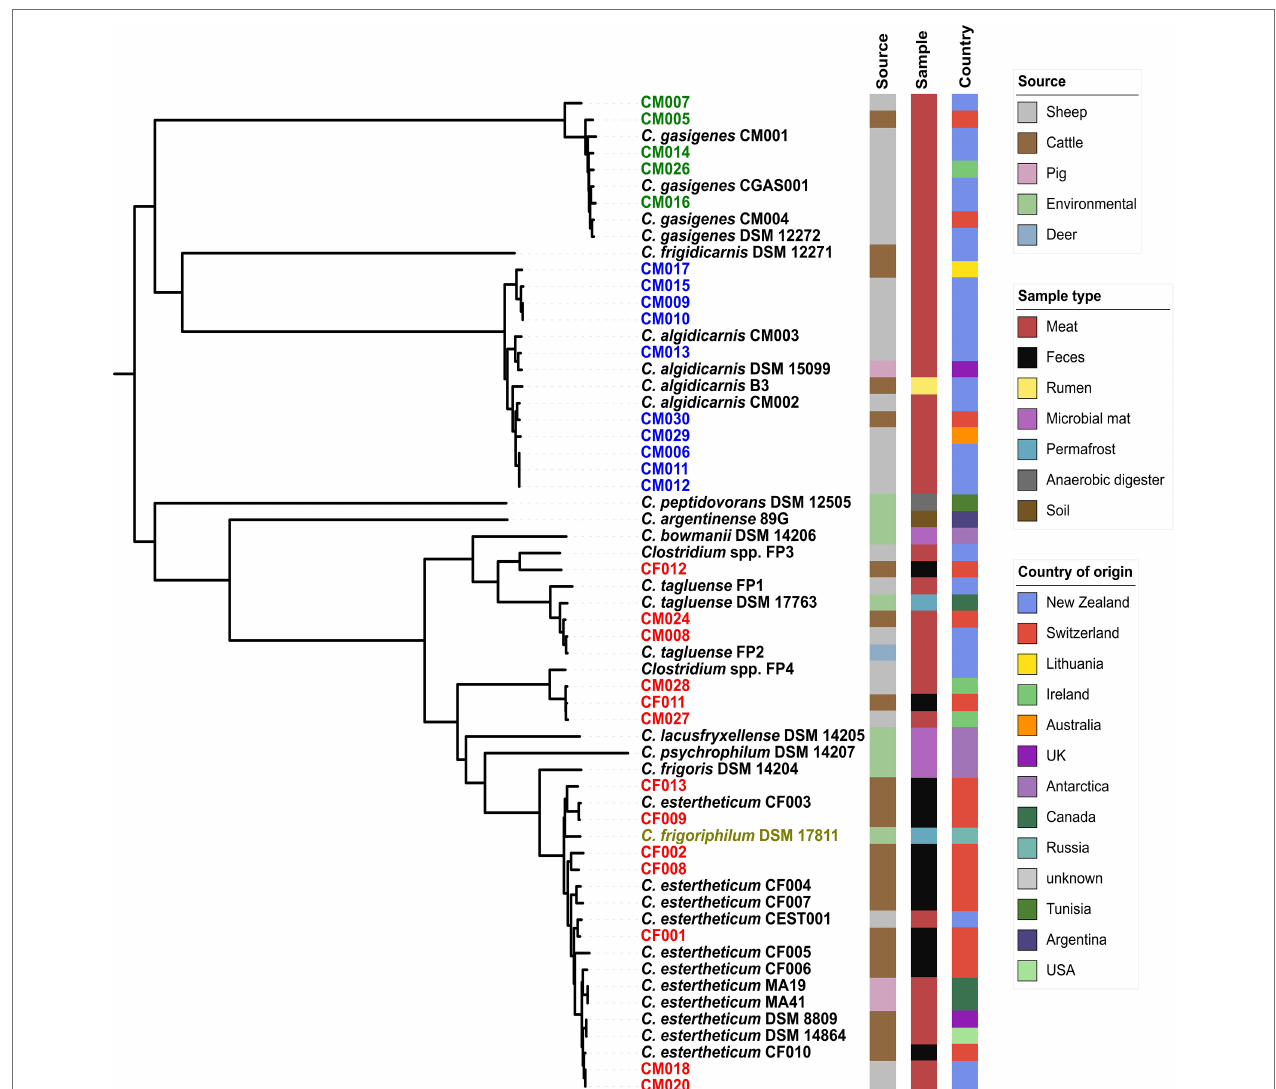
FIGURE 1 | Core-genome phylogenomic tree of 28 Clostridium spp. strains isolated from meat juice (MJS) and bovine fecal samples (BFS) and 32 representative clostridia strains. Thirteen isolates (red) clustered within the Clostridium estertheticum complex (CEC). Other isolates clustered within species C. algidicarnis (blue text; n = 10) and C. gasigenes (green text; n = 5). C. frigoriphilum DSM 17811 is highlighted in olive. On the right of the tree are metadata of the 60 clostridia